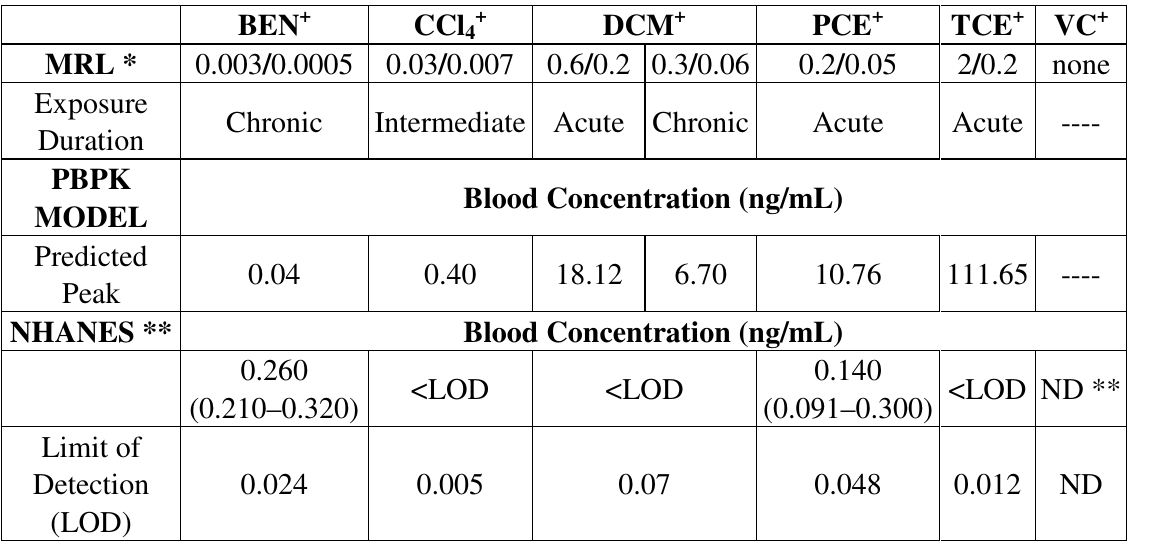
Table 2. Comparison of Minimal Risk Level ( MRL) simulated blood concentration of each solvent, assuming simultaneous inhalation (24 h/day) and oral ingestion (4 drinking bouts per day) to the measured blood concentration of solvent reported by National Health and Nutrition Examination Survey (NHANES) 2003–2004. The simulated solvent exposure is set to the MRL for inhalation of the solvent in air and ingestion of the solvent in water.